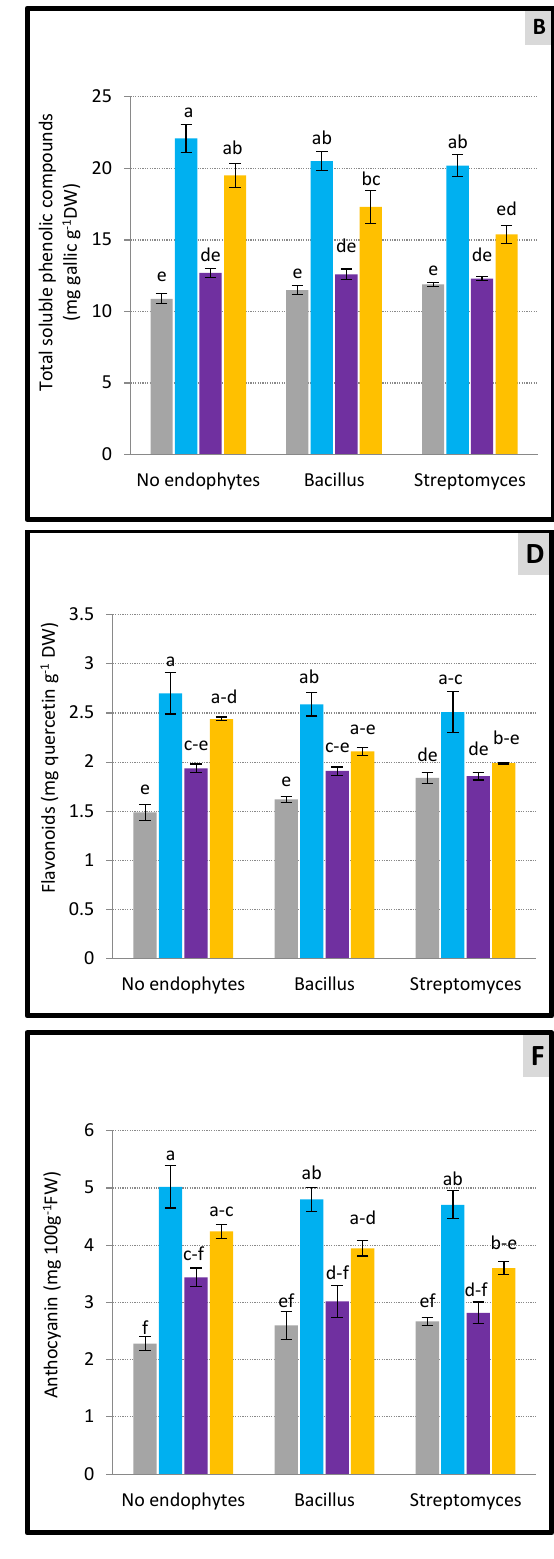
Figure 6. Interactive effect of endophytic microorganisms and abiotic elicitors on ( A , B ) total soluble phenolic compounds (TSPC, mg gallic g −1 DW), ( C , D ) flavonoids (mg quercetin g −1 DW), and ( E , F ) anthocyanin (mg 100 g −1 FW) of periwinkle plant shoot in both seasons. Columns with the same letter in each chart are non-significantly ( p ≤ 0.05) different according to Tukey’s test. Means of five replicates are presented with ±SE.